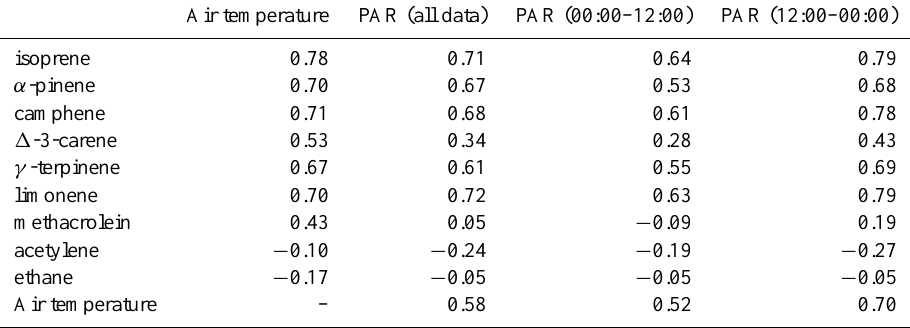
Table 2. Spearman’s rank correlation coefficients to demonstrate the degree of correlation between VOC mixing ratios with air temperature ( ◦ C) and PAR (µmolm − 2 s − 1 ) . Correlations with PAR are based upon 425 data pairs; temperature correlations are based on 534 data pairs (isoprene, acetylene and ethane) and 478 (monoterpenes and